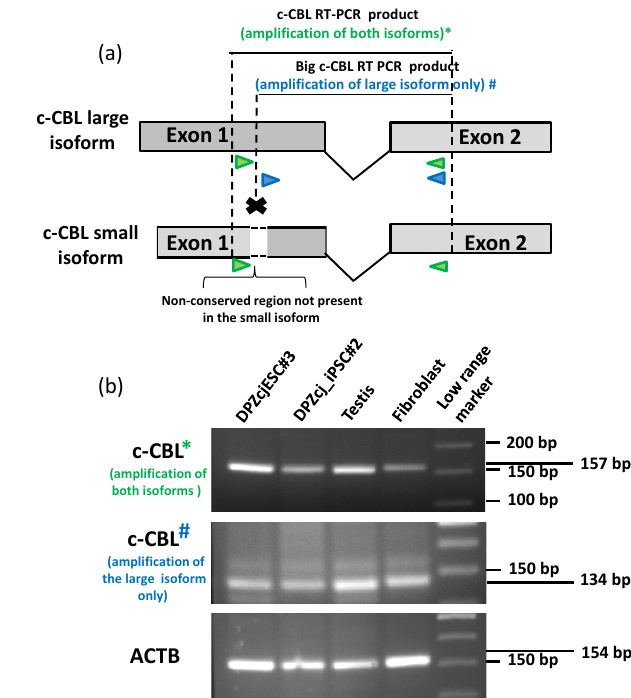
Figure 8. RT-PCR isoform confirmation of c-CBL transcripts. (a) Scheme of the two different RT-PCR approaches performed. The green arrows indicate the position of the primers used to amplify both isoforms simultaneously (RT-PCR 1). The blue arrows indi- cate the primers that allow for the specific amplification of the large isoform (RT-PCR 2), while the short isoform cannot be amplified. (b) High resolution agarose gel (3.5%) electrophoresis showing the results of RT-PCR 1, RT-PCR 2 and beta actin as control. The up- per gel clearly shows for RT-PCR 1 that the c-CBL band is slightly larger (157bp) than the 150bp fragment of the marker. In contrast to RT-PCR 1, RT-PCR 2 shows a band corresponding of the expected size of 134bp indicating also the expression of the larger